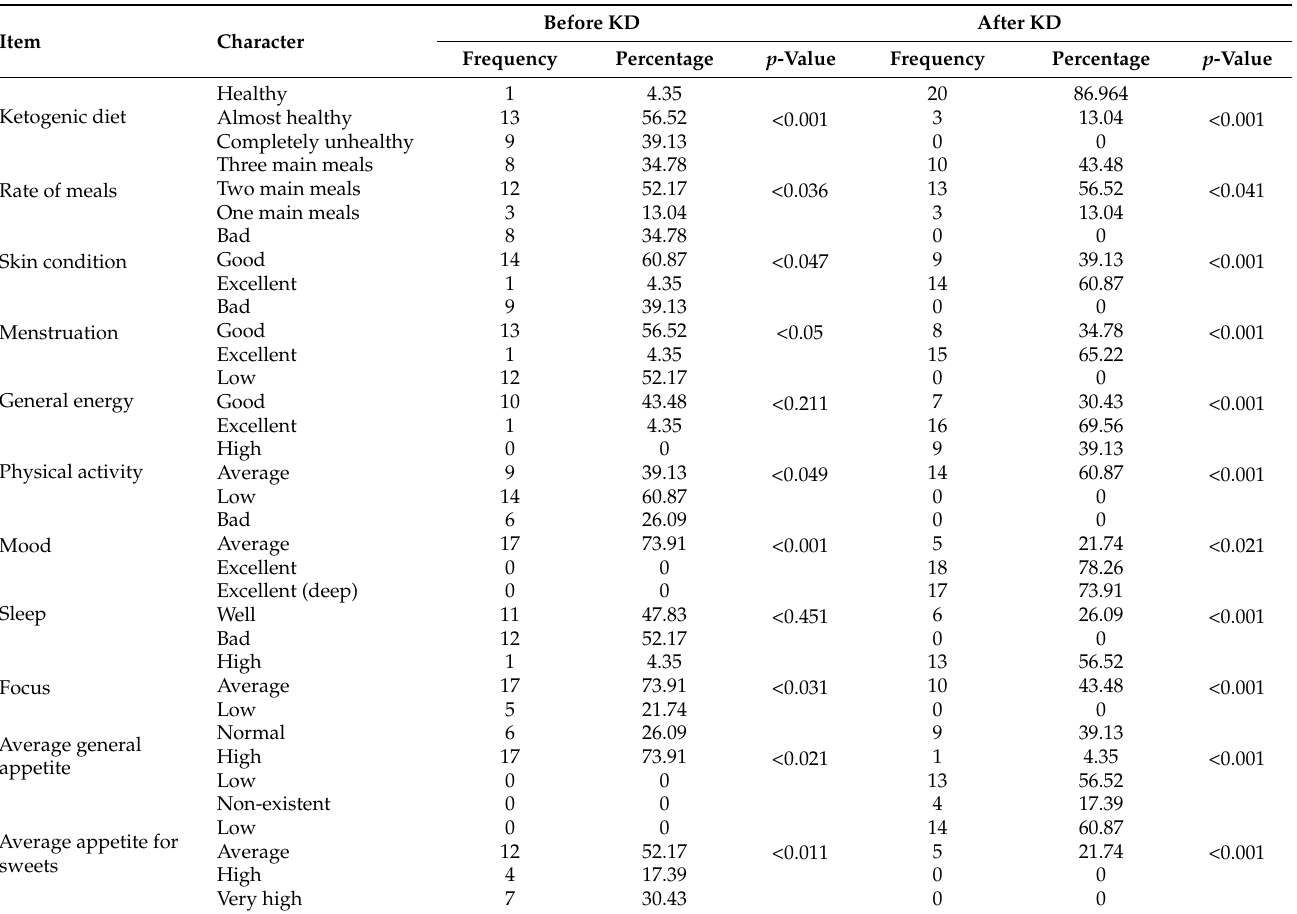
Table 5. Frequency distribution of the commitment of participants to the program and diet and the number of meals eaten per day and psychological state after completing the ketogenic diet